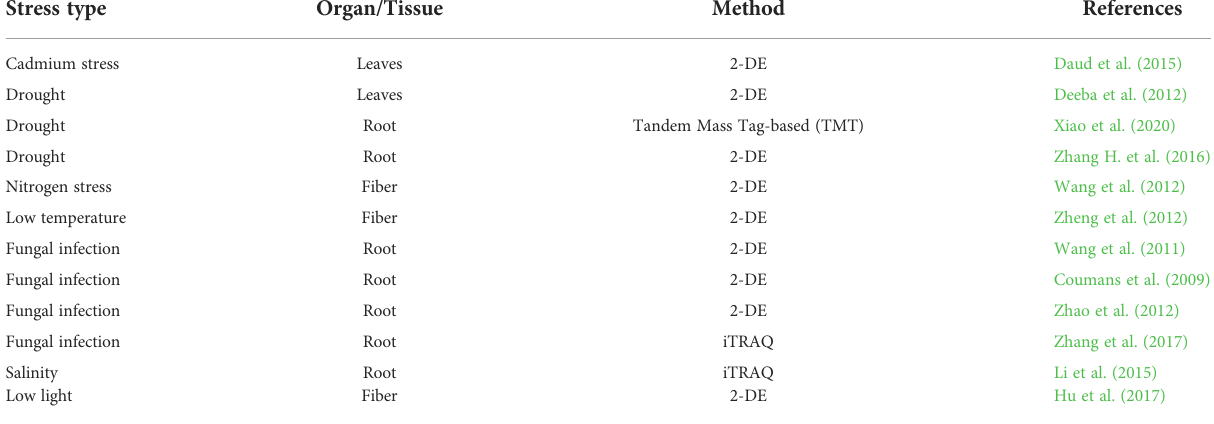
TABLE 1 Cotton proteomics studies according to stress type, tissue and method